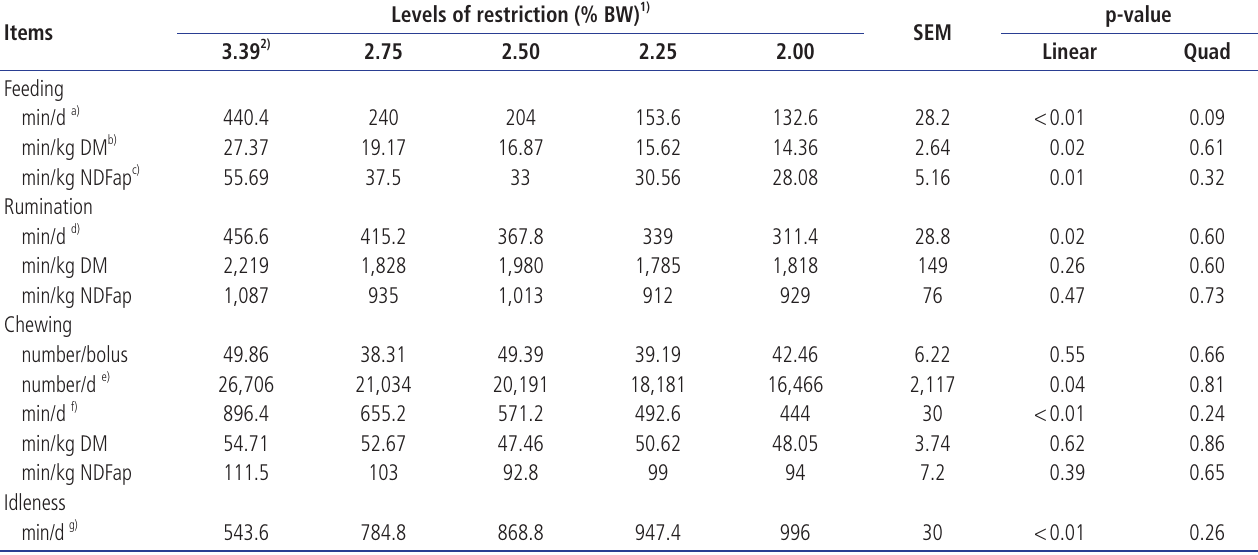
Table 4. Feeding behavior of F1 Holstein/Zebu cows under quantitative feed restriction in the middle third of